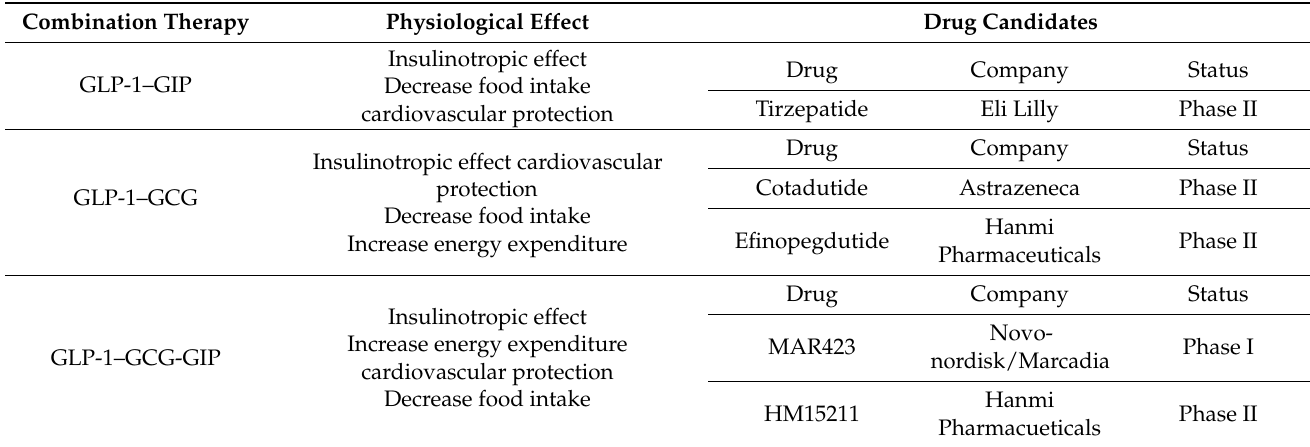
Table 2. An overview of several combination therapies with GLP-1R agonists that are currently in clinical